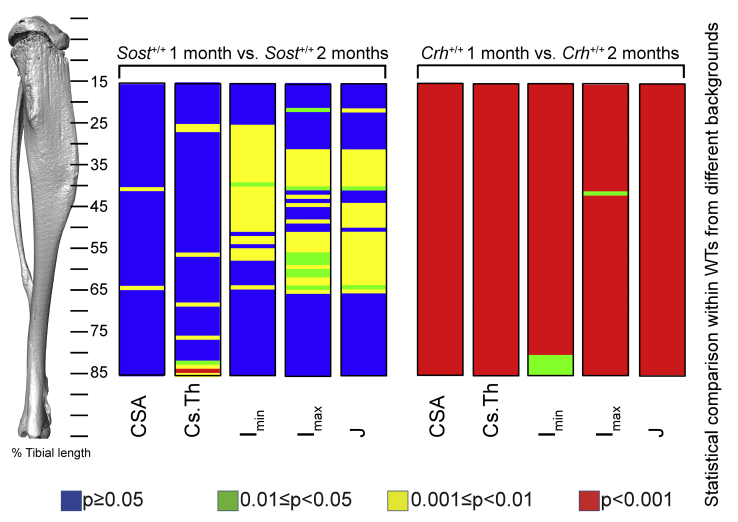
Graphic heatmap representation of statistical comparison within wild-type (WT) mice from different backgrounds. Sost+/+ and Crh+/+ at 1 month of age compared with Sost+/+ and Crh+/+ mice at 2 months of age for cross-sectional area (CSA), mean cortical thickness (Cs.Th), second area around minor axis (Imin), second area around major axis (Imax), and resistance to torsion (J). n = 8 mice per group.